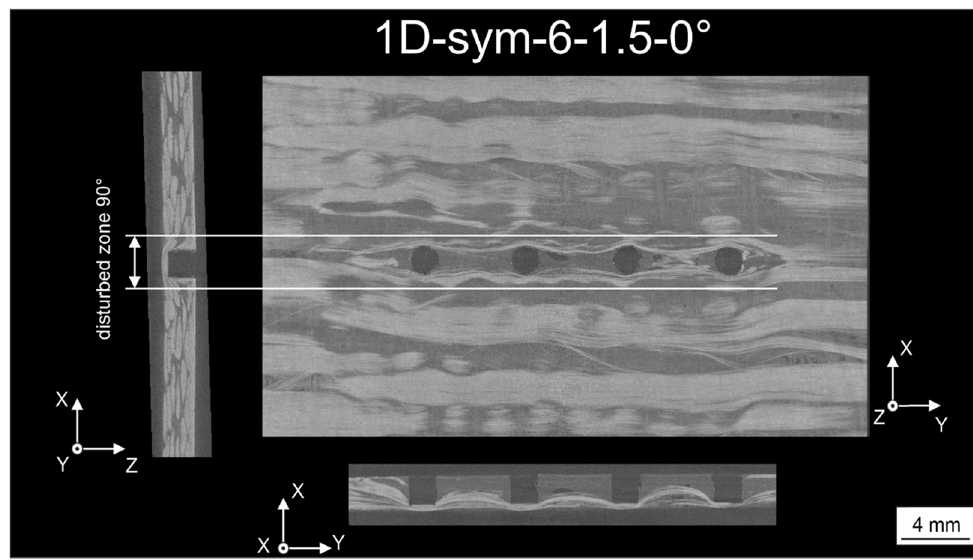
Figure 7: Example of 1D pin array with 0° array orientation.